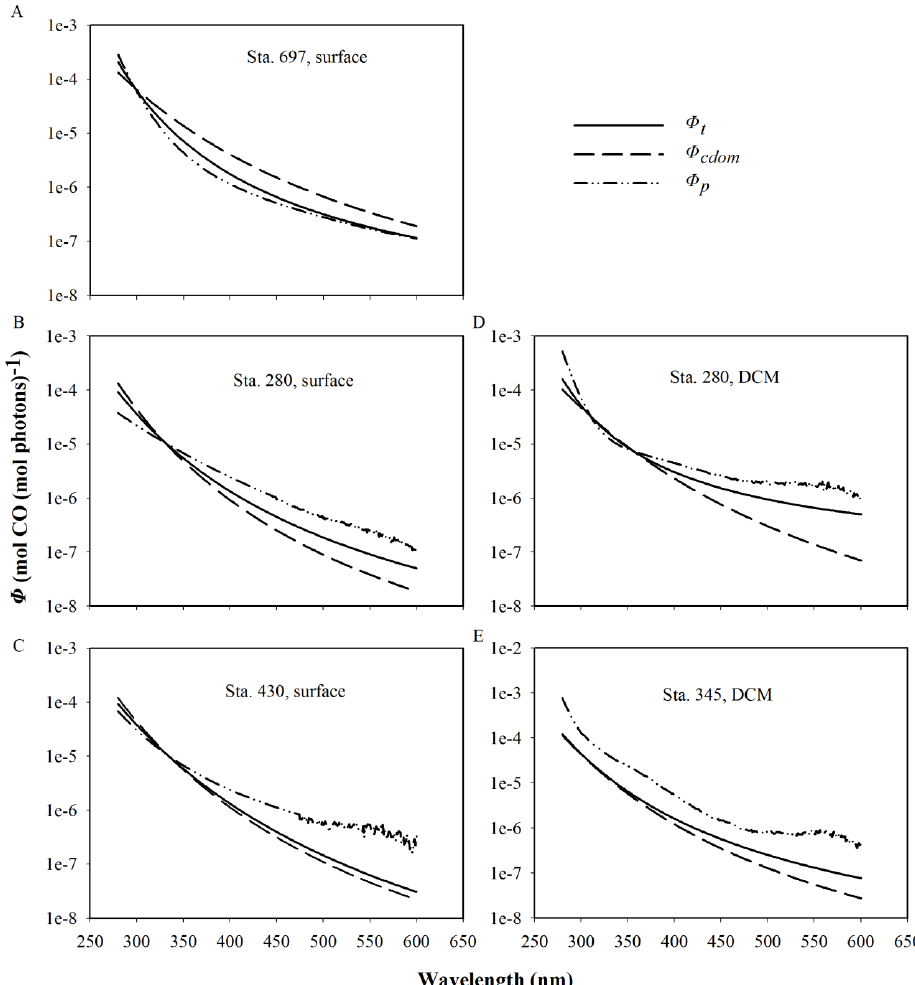
Fig. 2. Typical 8 cdom ,λ , 8 p ,λ , and 8 t ,λ spectra from the Mackenzie River estuary (Sta. 697), Mackenzie Shelf (Sta. 280), and Canada Basin Fig. 2. Typical Φ cdom,λ , Φ p,λ , and Φ t,λ spectra from the Mackenzie River estuary (Sta. 697), 3 (Sta. 345 and Mackenzie Shelf (Sta. 280), and Canada Basin (Sta. 345 and 430). 4